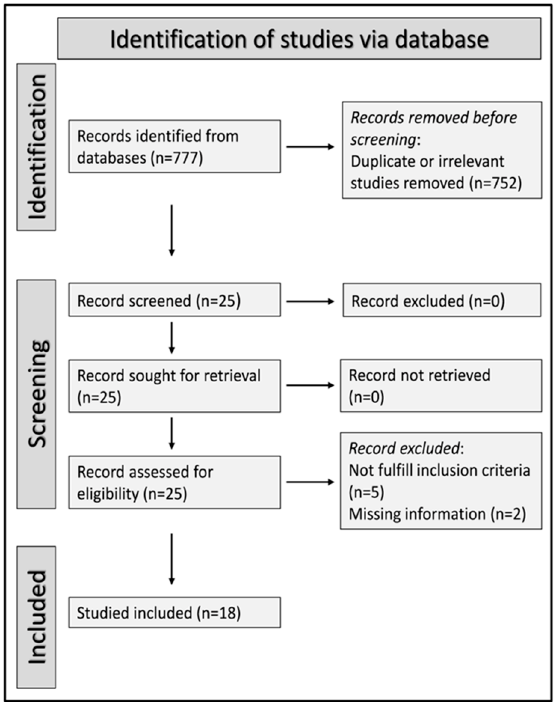
Figure 1. PRISMA 2020 flow diagram.